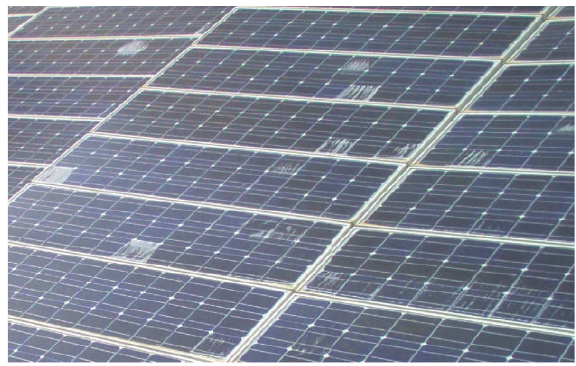
Figure 1: SIEMENS M55 PV generator subjected to lumps of mortar during the past.